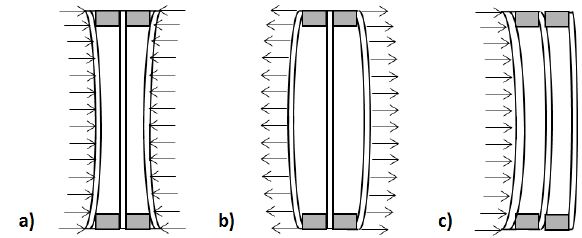
Figure 5: Typical deflections of insulated glass units: a) increase of external pressure or decrease of gas temperature in the gaps, b) decrease of external pressure or increase of gas temperature in the gaps, c) wind